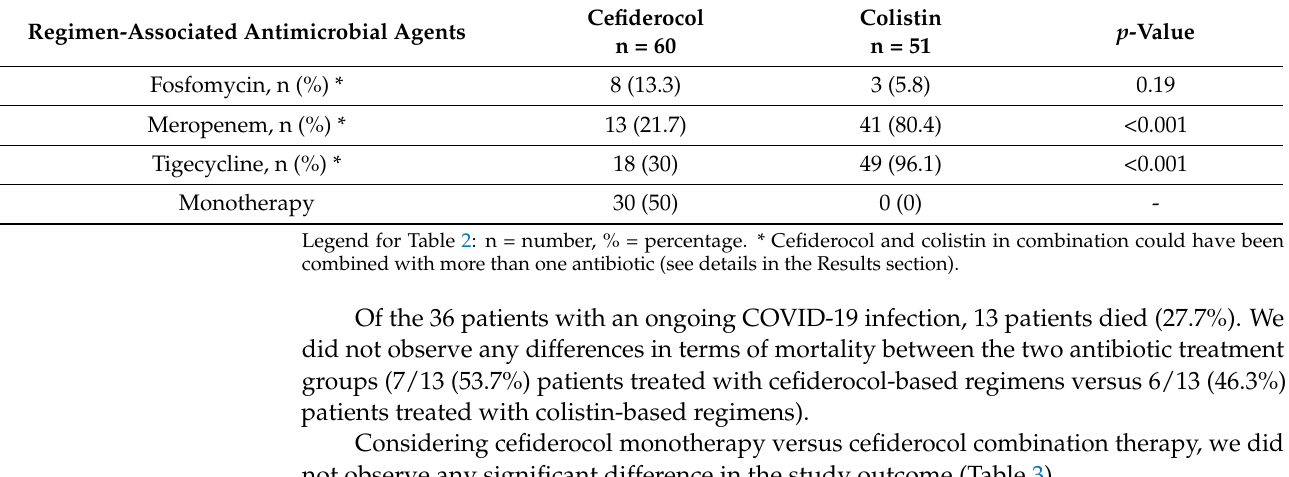
Table 2. Cefiderocol- and Colistin-associated treatment.